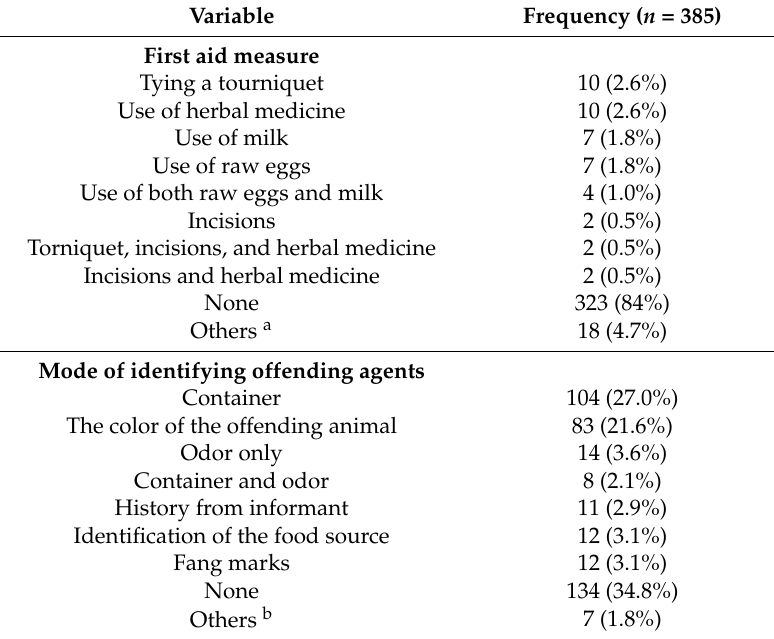
Table 5. Pre-hospital first aid measures among victims and methods used to identify offending